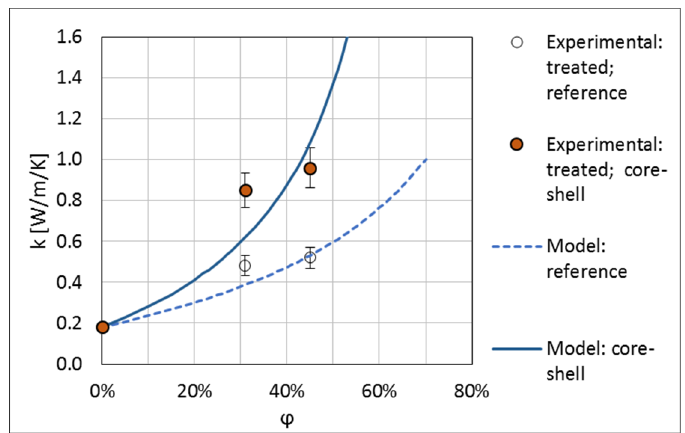
Figure 9. Thermal conductivity of composites with untreated fillers. The lines show the results of model calculations.